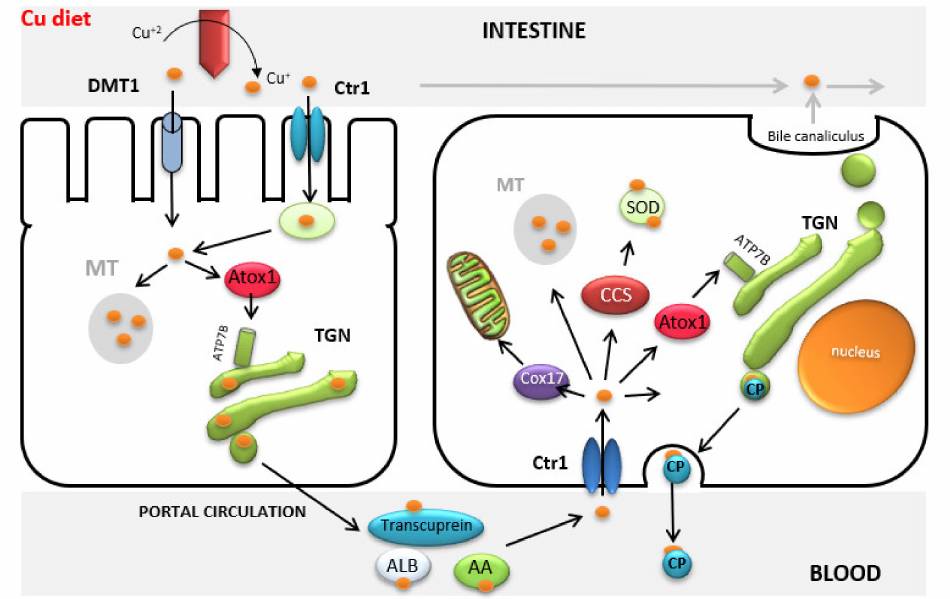
Figure 1. Copper transport. Ctr1: Copper specific transporter; DMT1: Divalent Metal Transporter 1; MT: Metallothionein; TGN: Trans Golgi Network; Cox17 and Atox1: Copper chaperone proteins; SOD: Superoxide dismutase; CP: Ceruloplasmin; CCS: Cytochrome c oxidase; ATP7B: Copper-transporting P-type